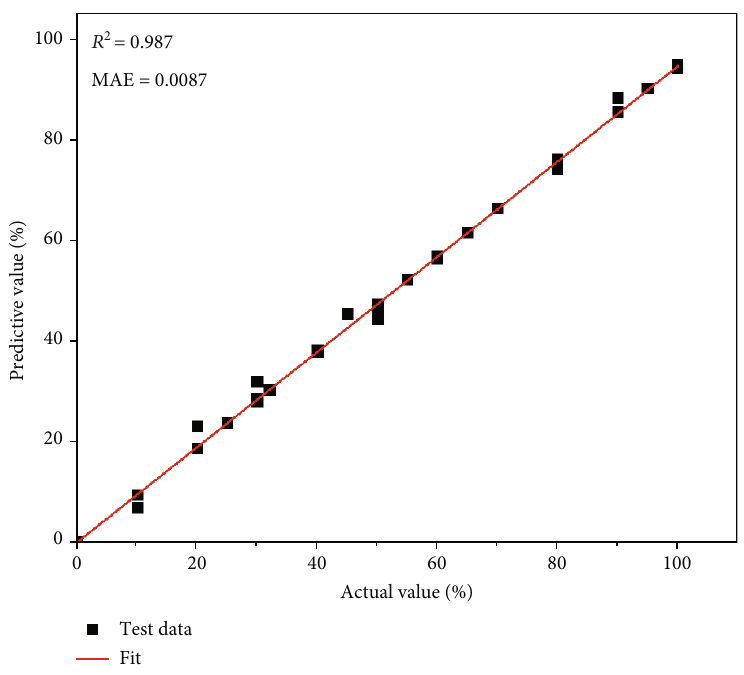
Figure 15: Model output and actual data: test data set.